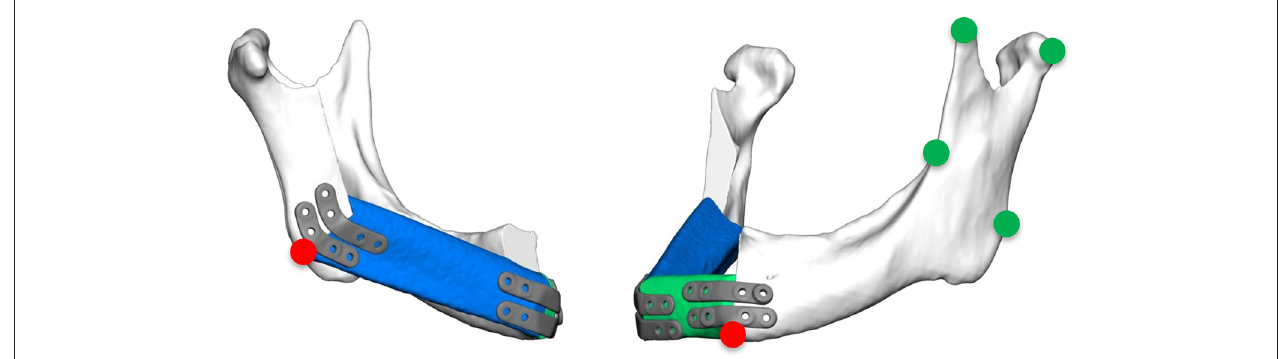
FIGURE 2 | Green marks: measurement points at the contralateral ascending ramus to evaluate the quality of fitting; red marks: measurement points at the base of the mandible at the connection of the original bone to the FFF and the most inferior point of the ipsilateral incisura